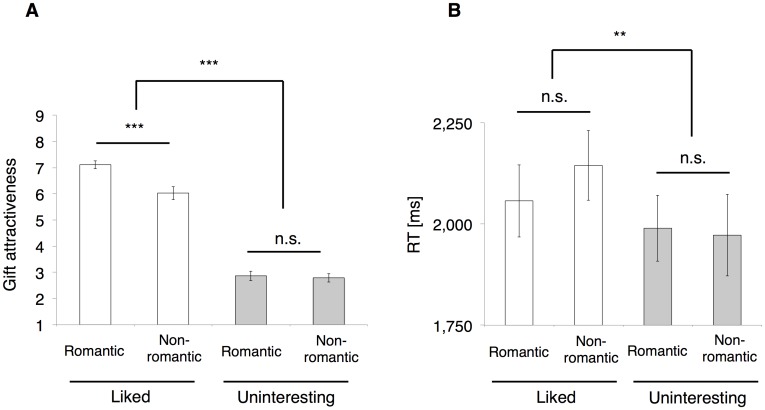
Behavioral results.(A) Mean gift attractiveness across the four target conditions showed significant main effects of both factors and a significant interaction between the two factors (n = 20, two-way repeated measures ANOVA, giver, p < 0.001; gift type, p < 0.01; interaction, p < 0.01). A pairwise comparison showed a difference in attractiveness between gift types for the liked giver (Bonferroni corrected p < 0.001) but not for the uninteresting giver. (B) Mean RT in value judgments across the four target conditions showed only significant main effect of giver (n = 20, two-way repeated measures ANOVA, p < 0.01). Bars show means, and error bars show s.e.m., ** p < 0.01, *** p < 0.001.